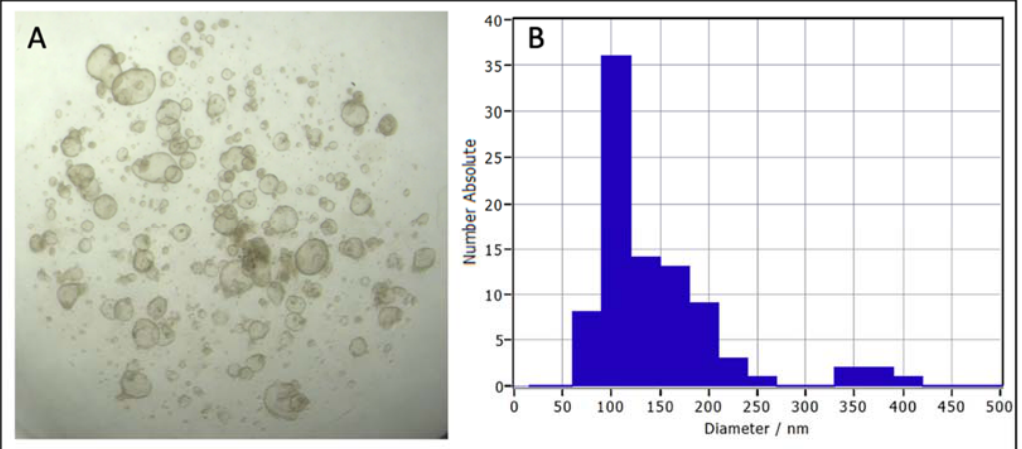
Figure 3. Bovine oviductal organoids after 14 days in culture ( A ), and a graph of nanoparticle tracking analysis (NTA) using ZetaView ® technology of the size distribution of extracellular vesicles collected from bovine oviductal organoid conditioned media following differential ultracentrifugation ( B ).